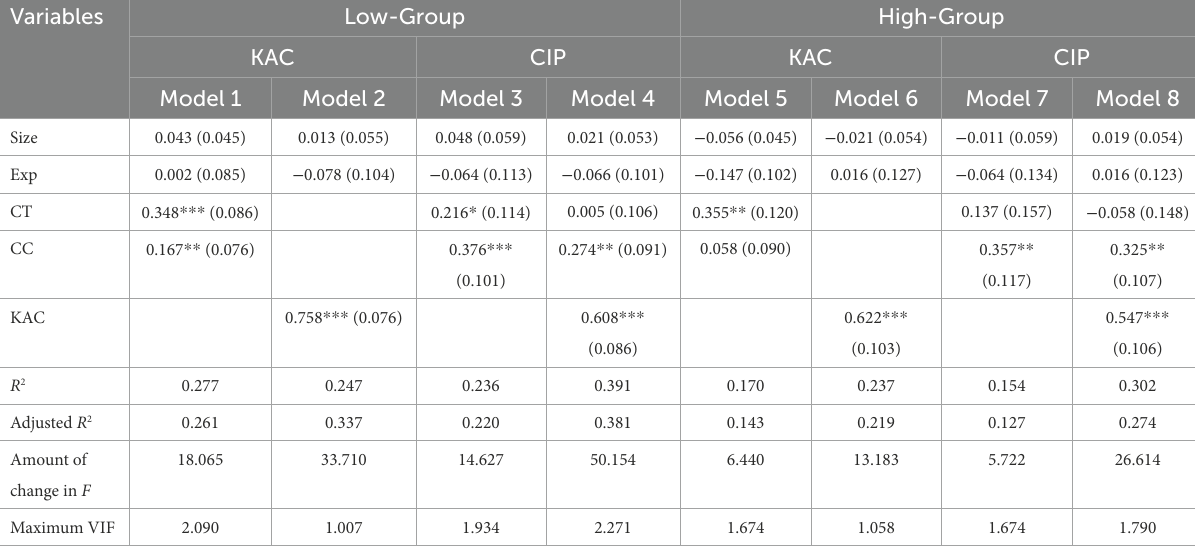
TABLE 7 Heterogeneity analysis of enterprise age.